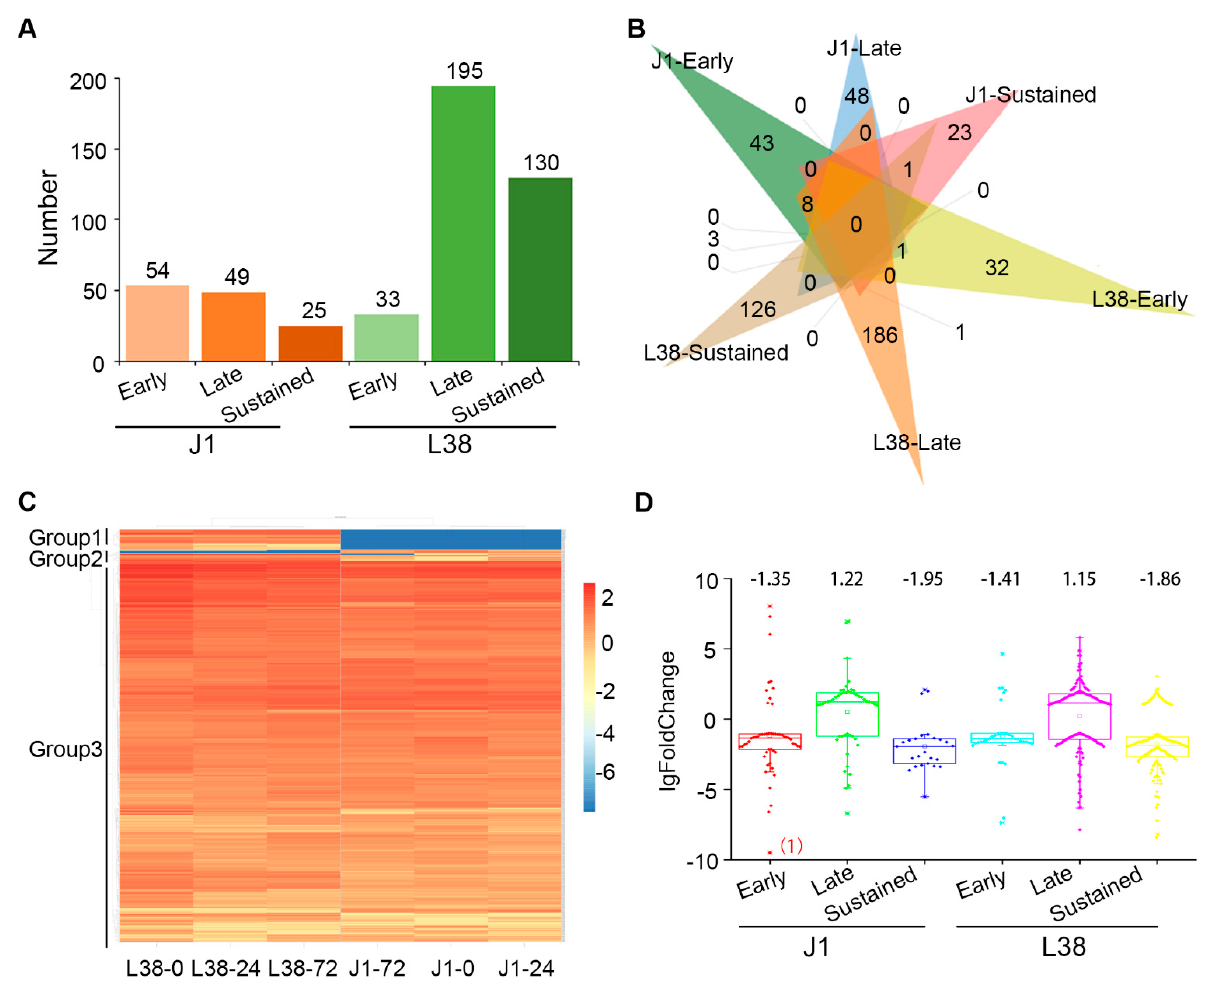
Figure 7. Characteristic of resistance gene analogues (RGAs) in J1 and L38 during Verticillium dahliae inoculation. ( A ) Number of RGAs in J1-early, J1-late, J1-sustained, L38-early, L38-late, and L38-sustained, respectively. ( B ) Venn diagram showed RGAs that were commonly and uniquely differentially expressed in J1-early, J1-late, J1-sustained, L38-early, L38-late, and L38-sustained, respectively. ( C ) Heatmap showed the time course expression profiles of RGAs annotated in J1 and L38 at 0 h, 24 h, and 72 h, respectively, which was performed by FPKM values of all genes. ( D ) The fold change of RGAs in J1-early, J1-late, J1-sustained, L38-early, L38-late, and L38-sustained. The number indicates the median of all log fold change of DEGs in each group, and the number in brackets indicates the number of RGAs for which log fold change was than − 10.